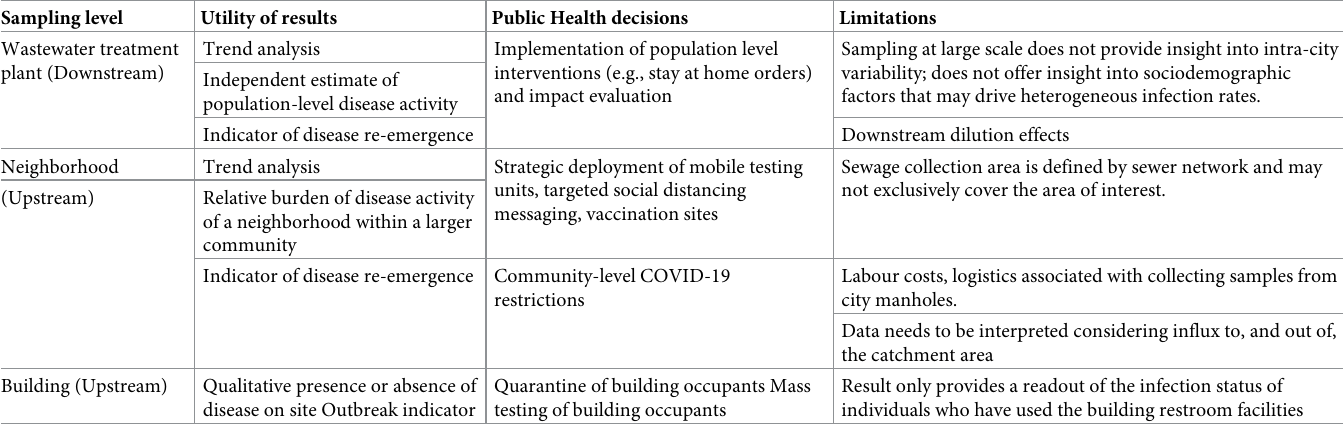
Table 1. Overview of wastewater geographic scales of sampling, utility of results, public health implications and